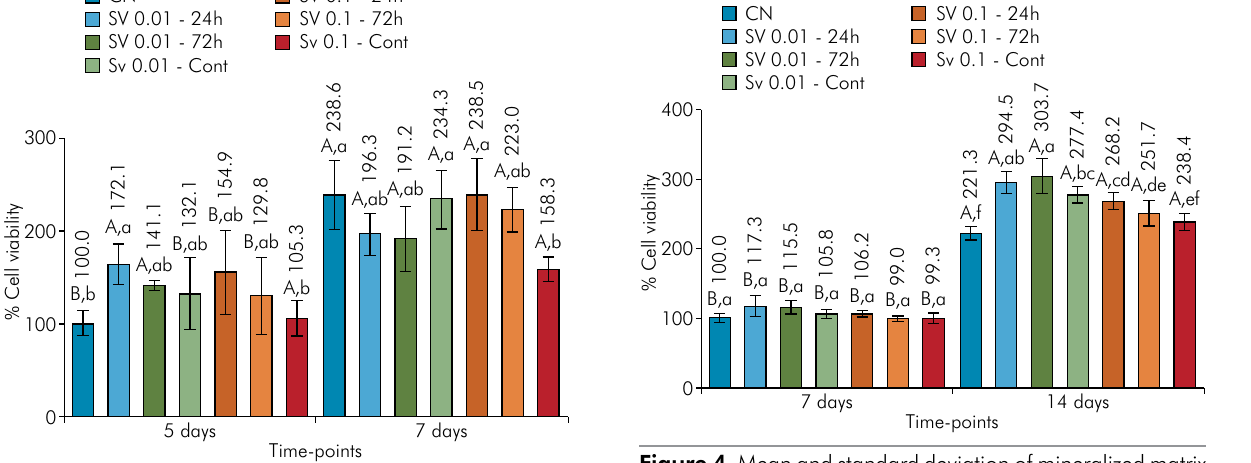
Figure 4. Mean and standard deviation of mineralized matrix deposition values (%) for each experimental group at the established time points. Uppercase letters allow comparison among the time points for each experimental group. Lowercase letters allow comparison among the groups within each time point. Different letters show significant differences (n=6; tests: ANOVA and Tukey; p <